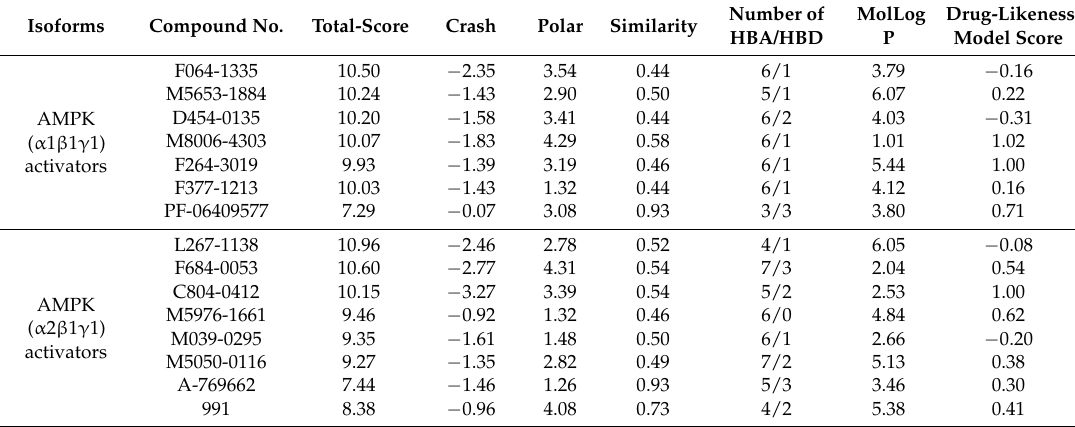
Table 1. The docking scores and drug-likeness model scores of selected activators for AMPK ( α 1 β 1 γ 1 and α 2 β 1 γ 1).